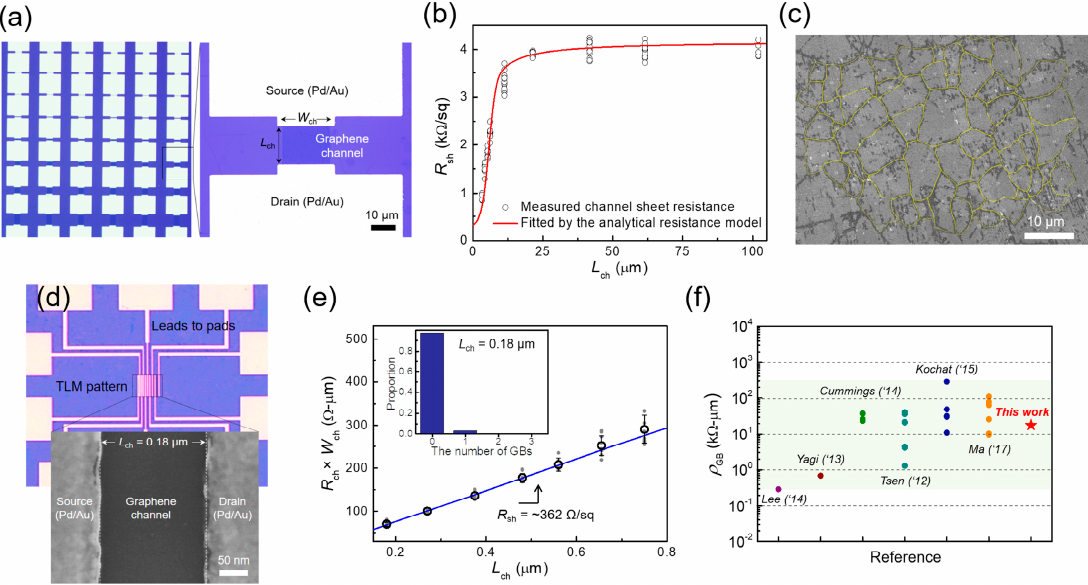
Figure 4. Experimental verification of the GB distribution-based analytical resistance model and parameter extraction method. ( a ) OM images of fabricated TLM patterns comprising the CVD-gra- phene FETs with varying channel lengths ( L ch of 2–100 μ m). ( b ) Measured channel sheet resistance as a function of channel length and fitting result using the analytical resistance model. The three- grain parameters extracted from the fitted model are ~5.95 μ m (for the average grain size), ~321 Ω /sq (for the average grain sheet resistance), and ~18.16 k Ω∙μ m (for the average GB resistivity). ( c ) The representative SEM image of CVD graphene grown on a Cu foil, with UV/ozone-treated GBs high- lighted in yellow. The average grain size estimated from 376 grains is 5.88 ± 1.5 μ m. ( d ) OM and SEM image of a fabricated TLM pattern comprising the graphene FETs with sub-micrometer chan- nel lengths ( L ch of 0.18–0.75 μ m). ( e ) The measured width-normalized channel resistance as a func- tion of the channel length, in which the linear slope indicates the sheet resistance of single-crystalline grains due to the extremely low probability of the presence of GBs within the short-channel regions. Inset: the histogram distribution of the number of GBs when the channel length is significantly smaller than the average grain size ( L ch = 0.18 μ m and l G = 5 μ m). ( f ) Summary of experimental results for the GB resistivity reported in the literature [4–6,25–28], where all represented resistivity values were extracted at the charge neutrality point. This summary plot shows that the GB resistivity ex- tracted in this study falls within the range of the reported resistivity values.